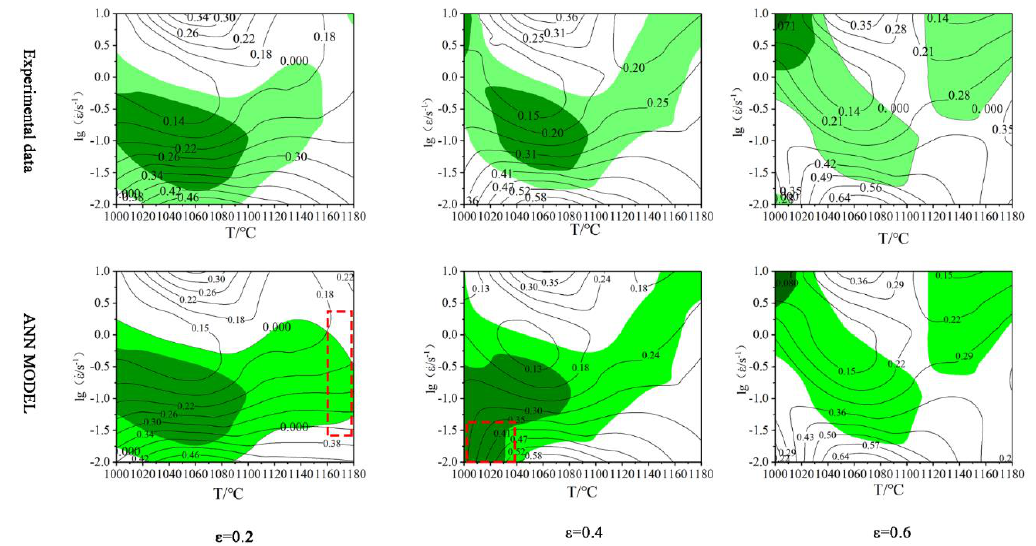
Figure 10. Comparison of processing map: the shaded areas are unstable areas, and the probability of instability is proportional to the color depth.